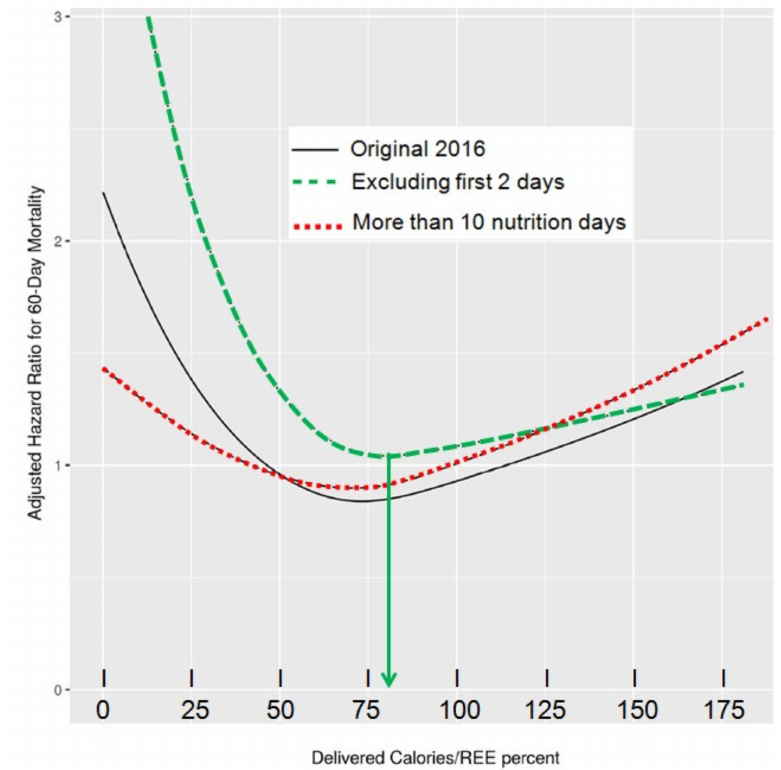
Figure 4. Association of delivered calories / resting energy expenditure (REE) percent by indirect calorimetry (IC) with 60-day mortality in di ff erent models: the authors recalculated their original 2016 data to integrate the fact that energy delivery increased progressively during the initial 2–3 days, reducing the mean value in stays < 5 days. The lowest ICU mortality was observed when percent of delivered calories by REE obtained by IC was 80% (excluding first two feeding days) and 75% (with > 10 evaluable nutrition days) ( p < 0.05). On the contrary, increments of the ratio above that point—specifically > 110%—were associated with increasing mortality ( p < 0.05). Reproduced